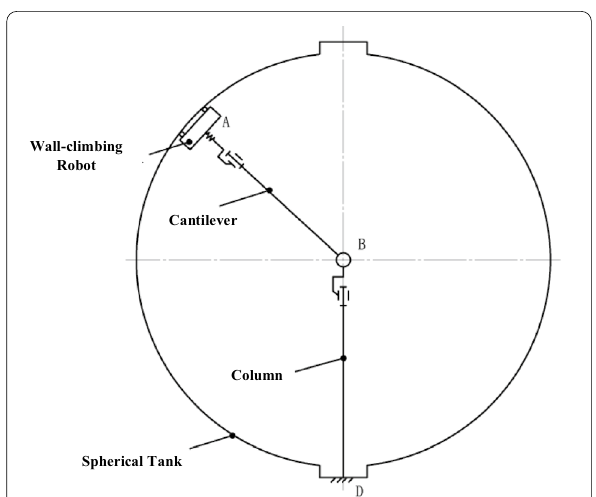
Figure 1 Working principle of the support